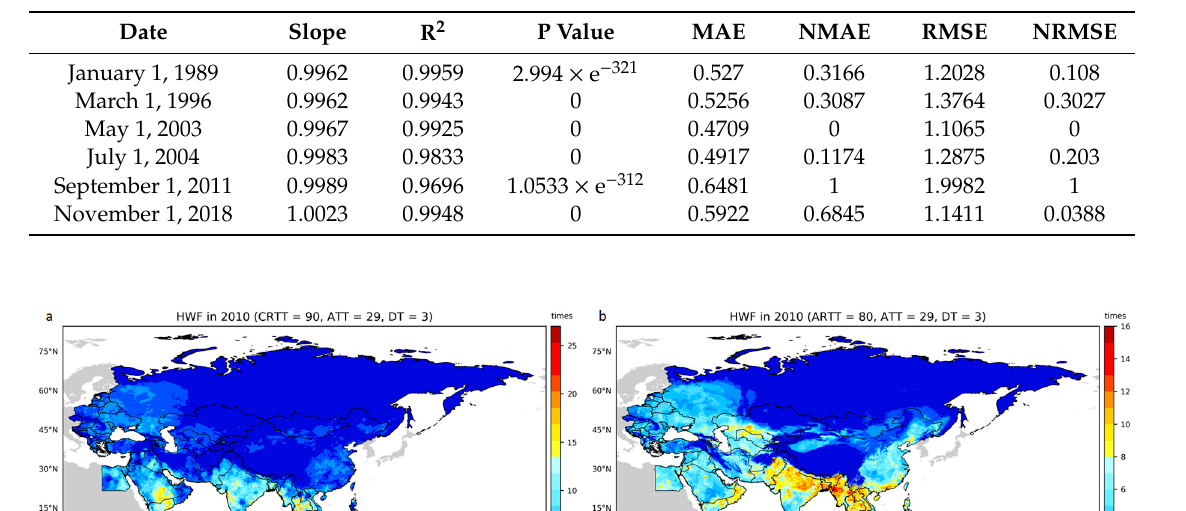
Table 3. Validation result.